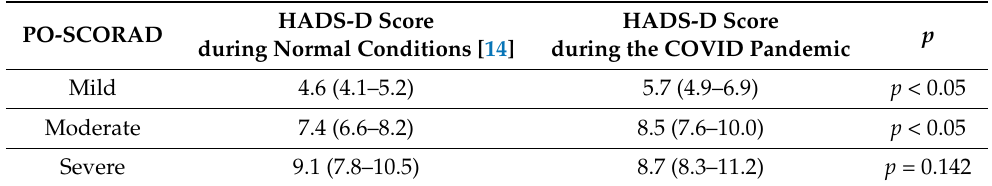
Table 2. Diagnosis of depression during COVID-19 compared to the scores during normal conditions. HADS-D Score HADS-D Score PO-SCORAD during Normal Conditions [14] during the COVID Pandemic